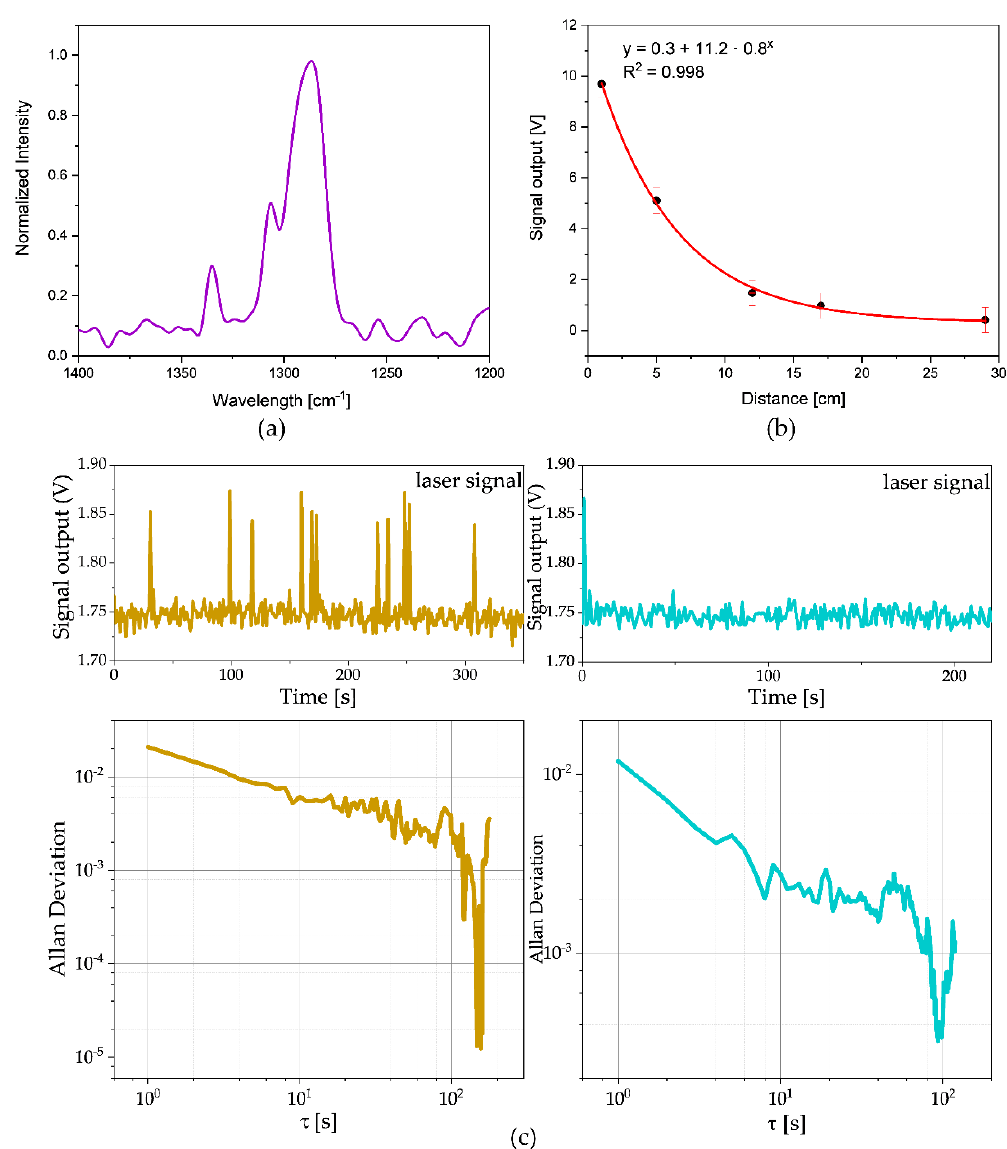
Figure 3. Characteristics of the Fabry–P é rot laser. ( a ) The emission spectrum of the laser treated with a seven-point FFT filter; ( b ) Signal decay as a function of distance between laser and detector. ( c ) Exemplary tryptophan spectra (top) and Allan variance of the laser (bottom). The colors are in accordance with Figure 4b, indicating the different measurements (yellow is the third measurement in Figure 4b and blue is the second measurement in Figure 4b).